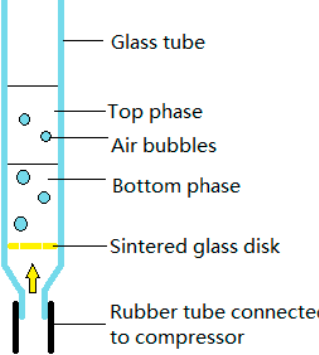
Figure 1. Figure illustrating schematic diagram of LBF system.